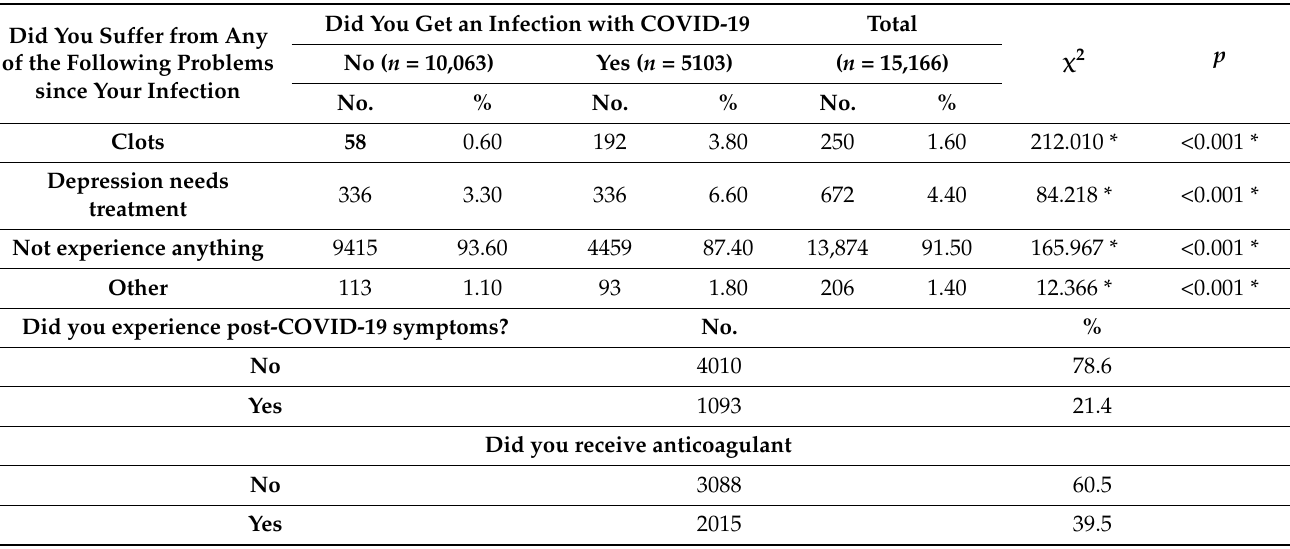
Table 5. The experienced complications among COVID-19 infected